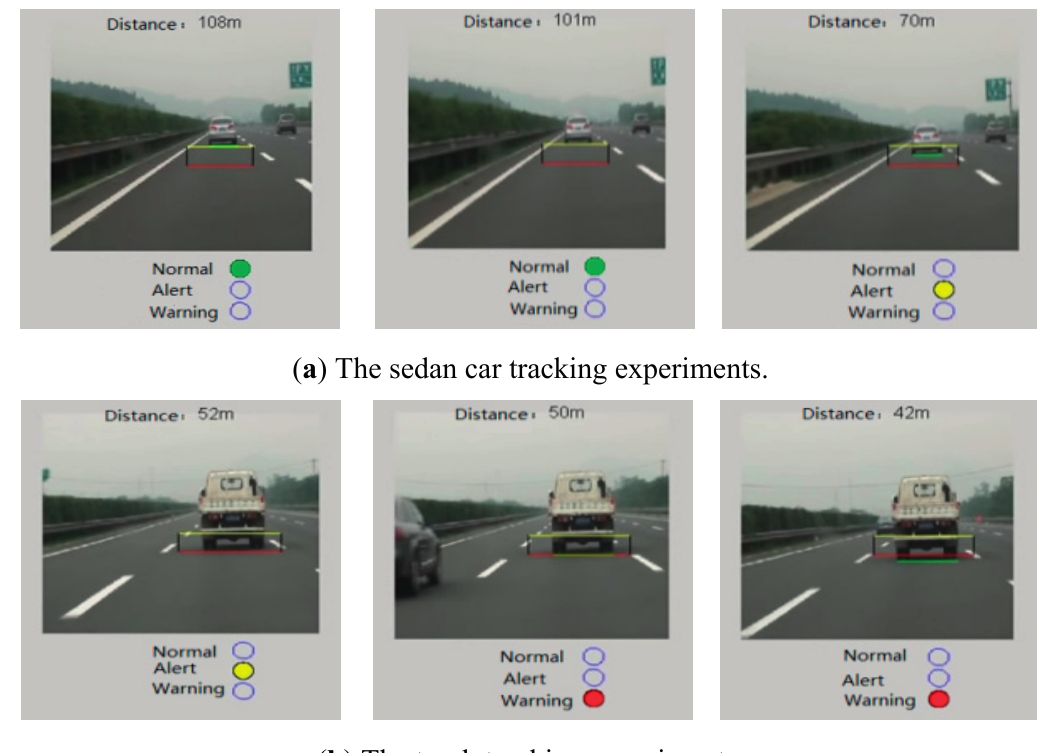
Figure 21. Partial tracking result with different